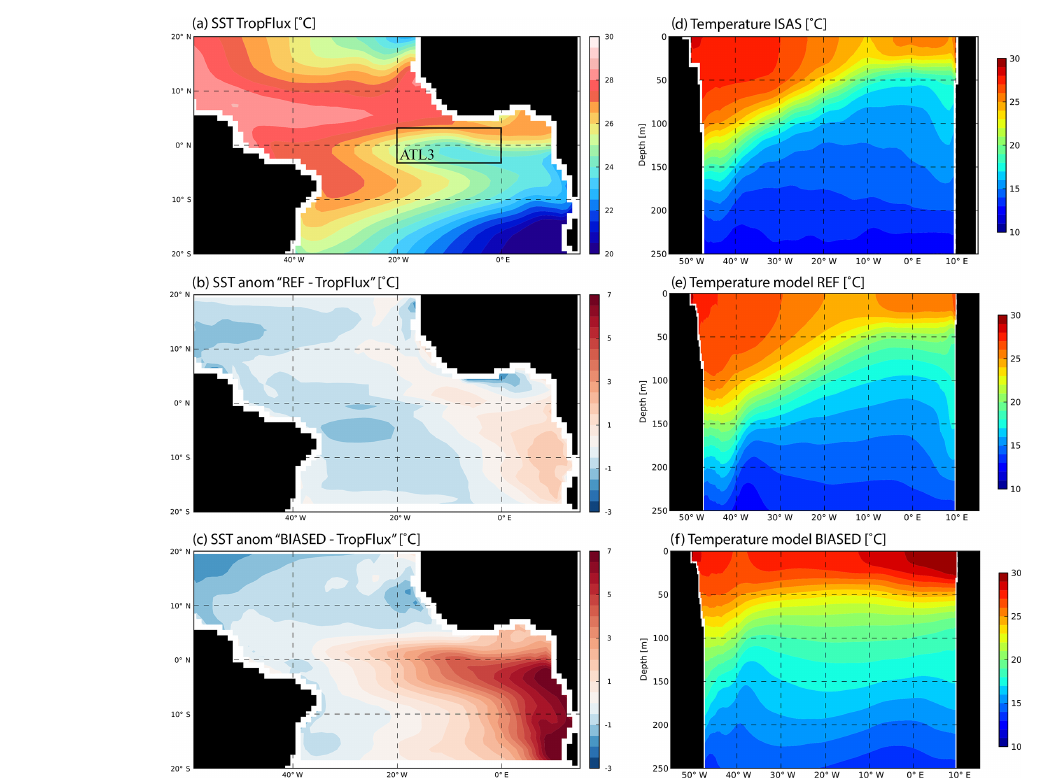
Figure 1. Climatological SST ( ◦ C) in June–July–August for the period 1979–2015 from TropFlux (a) and anomalies of SST between simulation REF and TropFlux (b) and between simulation BIASED and TropFlux (c) . Zonal sections of June–July–August temperatures ( ◦ C) averaged between 2 ◦ S and 2 ◦ N from ISAS observations (d) , REF (e) and BIASED (f)